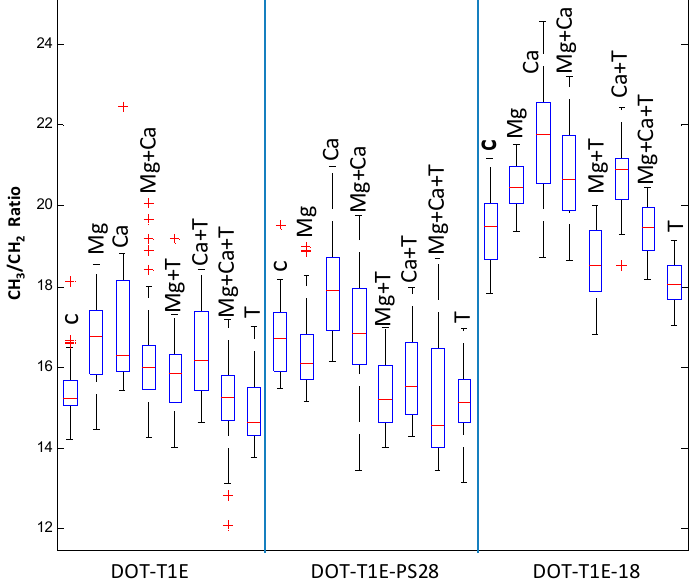
Figure 5. Box-whisker plot for FT-IR scaled spectra showing the ratio of saturated fatty acids (CH 3 :CH 2 ) of P. putida DOT-T1E strains grown strains in LB medium supplemented with or without 7 mM magnesium and 3 mM calcium in the absence and presence of 0.05% ( v / v ) toluene. Red lines indicate the median of peak area of saturated fatty acid ratio of infrared spectra. The median was used to compare the level of saturated fatty acid ratio. Red plus signs represent the